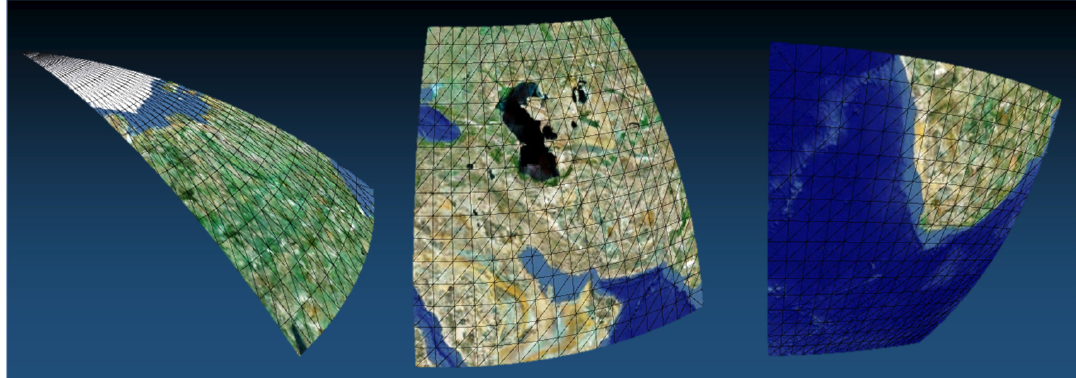
Figure 4. Example of the implementation of our 3D terrain model: tile surfaces are curved to represent a spherical globe.